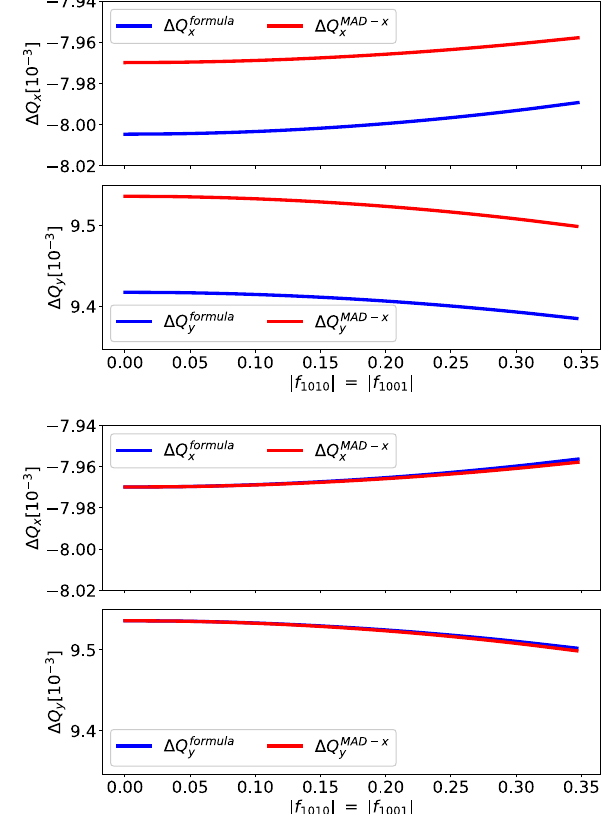
FIG. 2. Comparison of tune change from quadrupole modula- tion with coupling to MAD-X simulations. (Top) Tune change from Eq. (30) compared to MAD-X simulations. (Bottom) Tune change from Eq. (33) compared to MAD-X simulations.